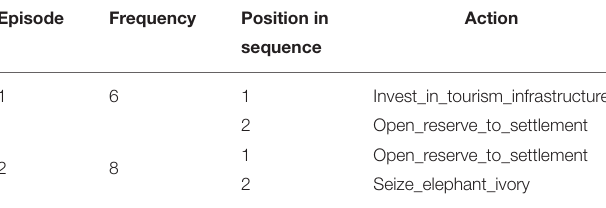
TABLE 4 | Episodes in the East African cheetah database that contain the habitat-destroying EMAT action of open reserve to settlement . Episode Frequency Position in